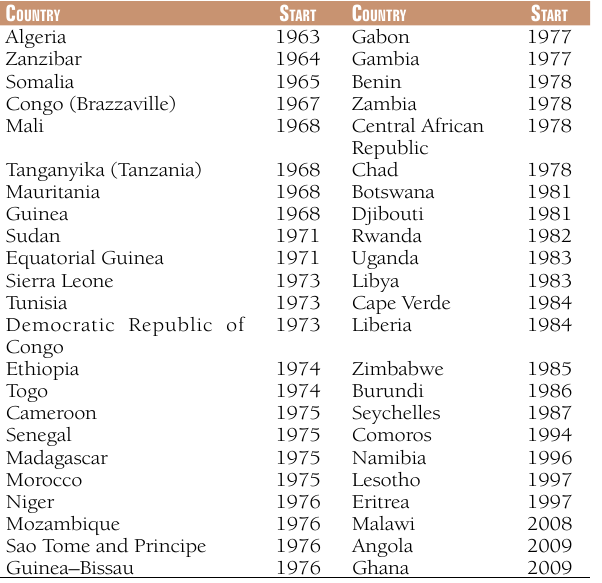
Table 1. African recipient countries and their starting year of receiving China's medical assistance C ountry S